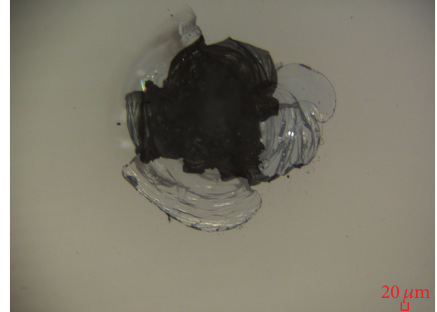
Figure 9: The optical micrographs of the damage